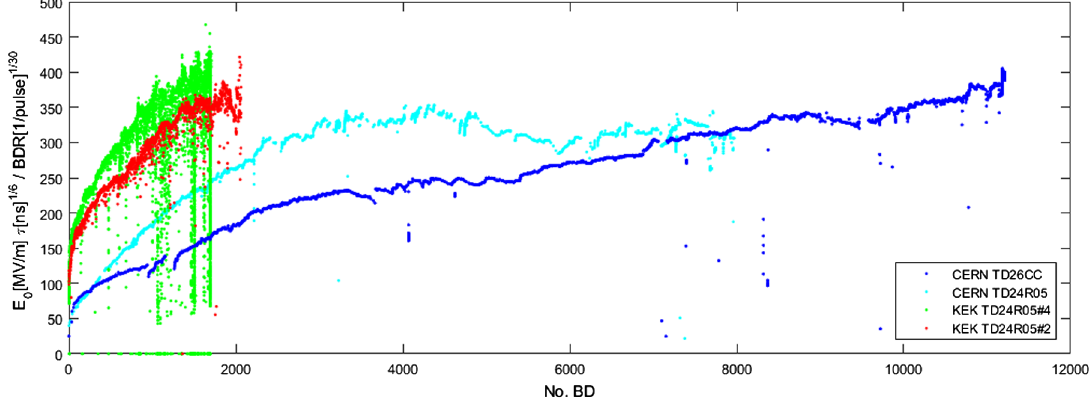
FIG. 4. Comparison of the scaled gradient vs number of accumulated breakdowns for several structures. When plotted with respect to the total accumulated number of breakdowns, the curves of the scaled gradient diverge significantly.